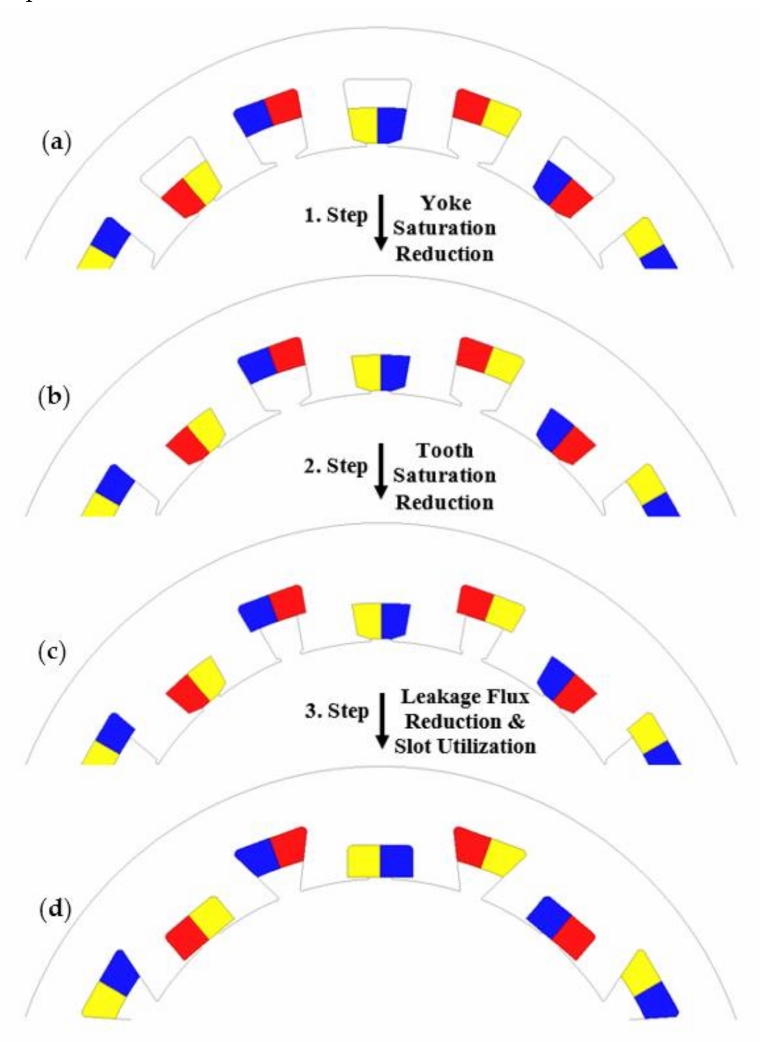
Figure 11. Improvement sequence of AIM. ( a ) Yoke saturation reduction; ( b ) tooth saturation reduction; ( c ) leakage flux reduction and slot utilization; ( d ) final